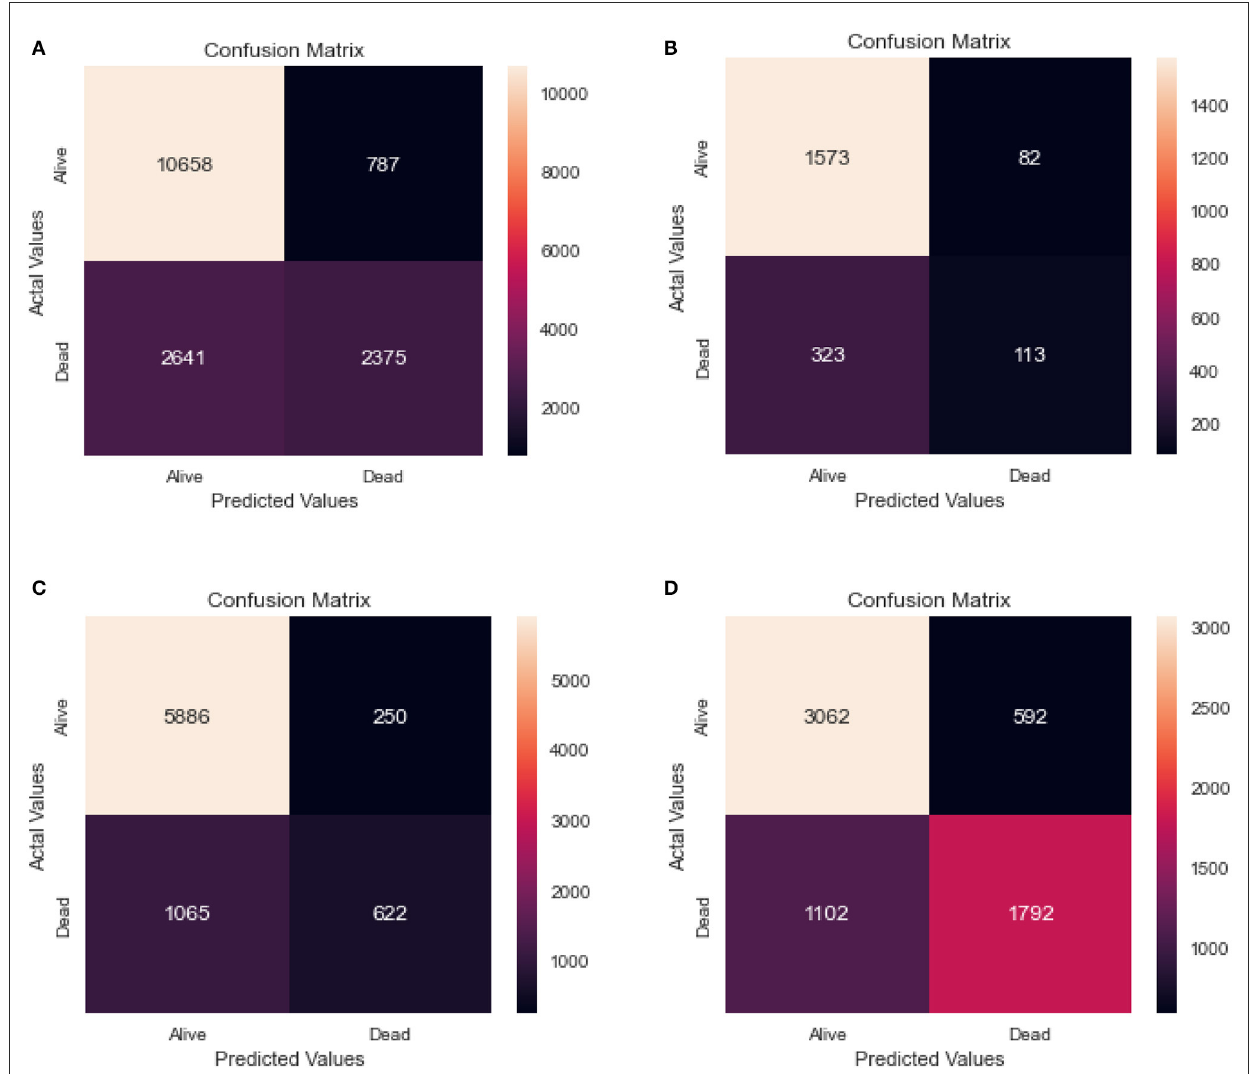
matrix for the same model for the different age groups is shown in Figure